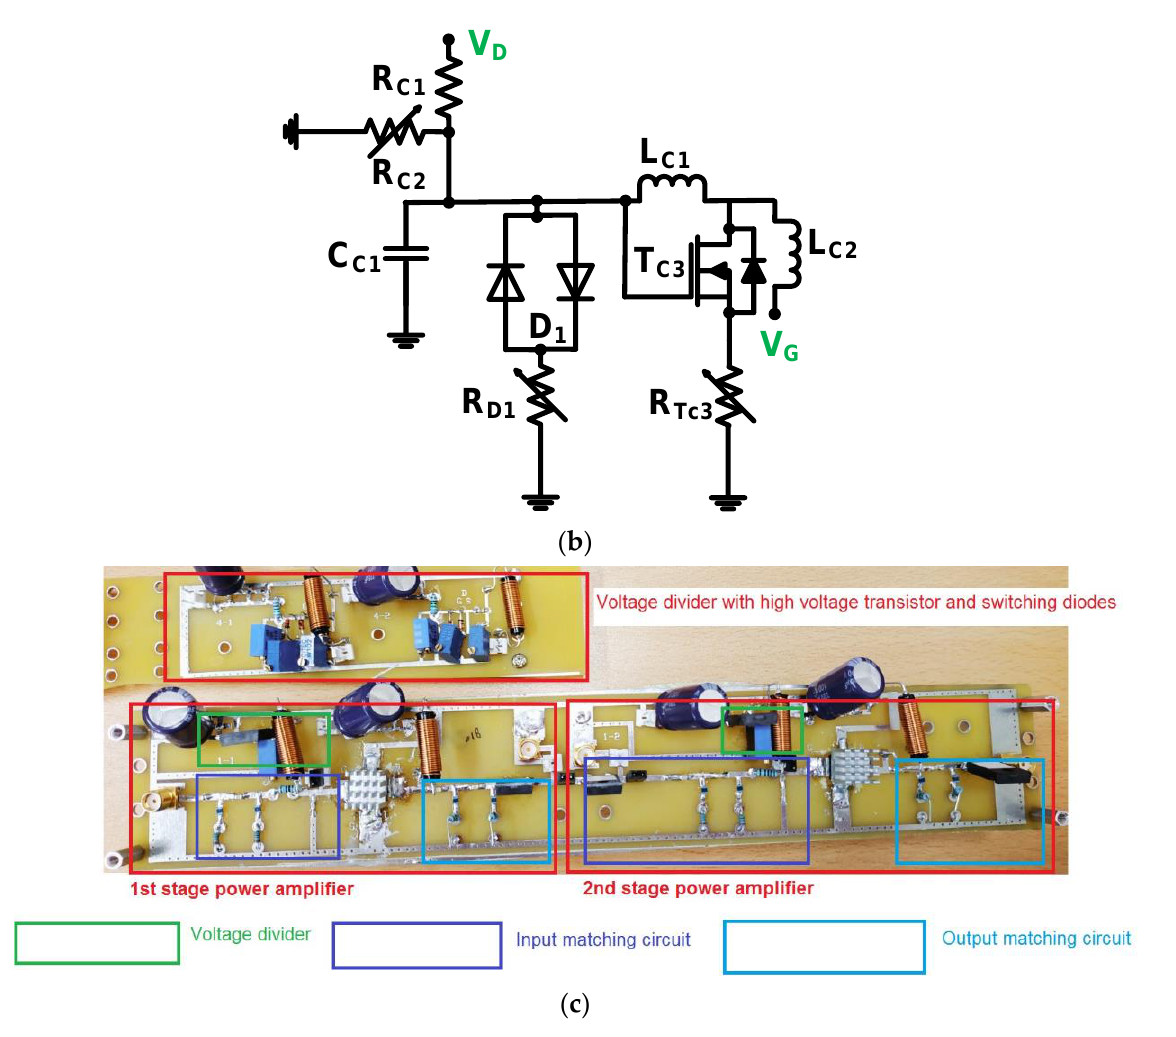
Figure 2. ( a ) Schematic of Class-C pulsed power amplifier with voltage divider; ( b ) schematic of voltage divider integrated with transistor and switching diodes; and ( c ) implemented printed circuit board of Class-C pulsed power amplifier structures.